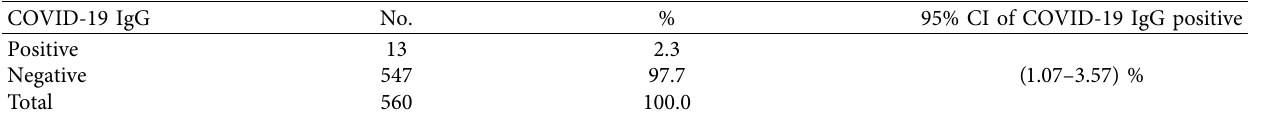
Table 7: COVID-19 antibody status among healthcare workers.